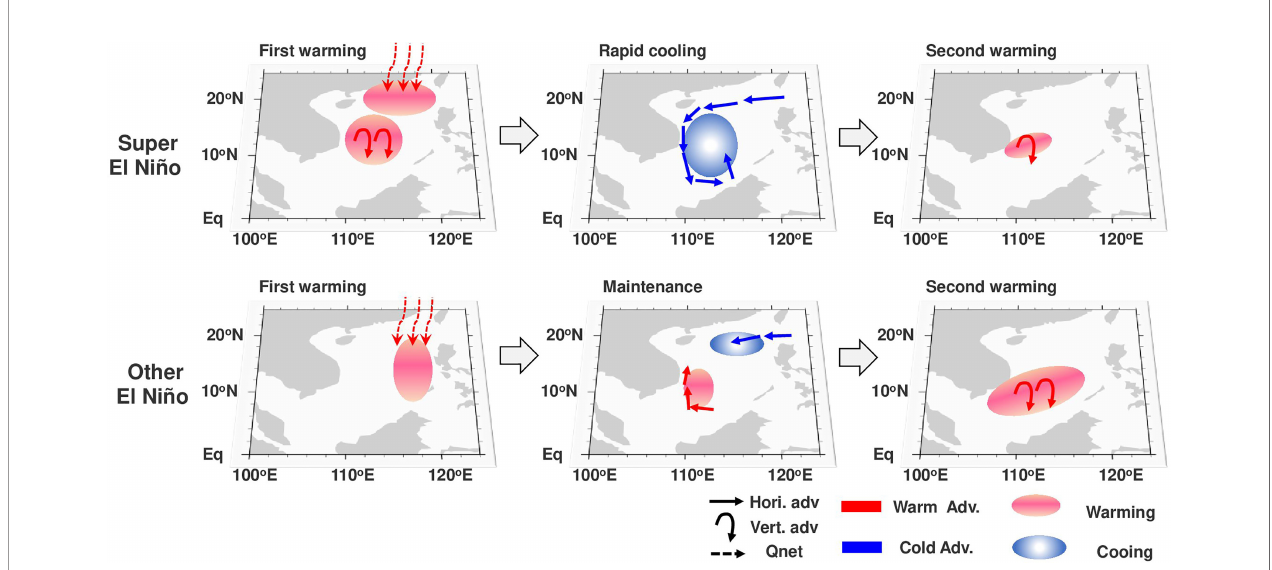
FIGURE 13 | Schematic illustrating the discrepant effects of oceanic advection in the evolution of SCS SST anomalies during El Niño of different